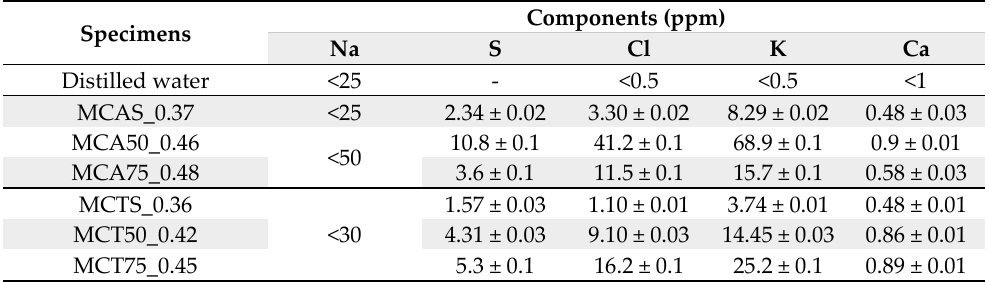
Table 6. Leached concentration results after specimens’ submersion for 48 ± 0.5 h in distilled water.